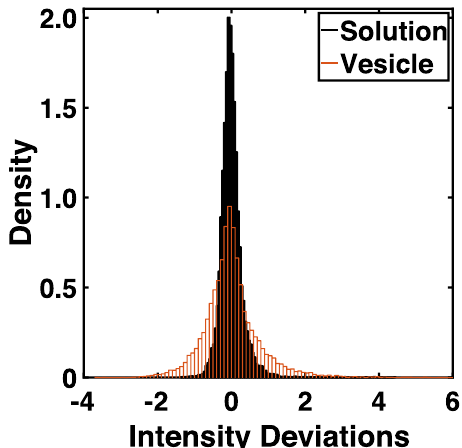
Fig. 2 | Peptides on vesicles at the estimated poration are not distributed randomly. The intensity deviations in solution (black) are narrower around 0 deviation (mean= − 3.9e-5, variance=0.096) while the intensity deviations for the bound peptide (red) include deviations greater than the largest deviations observed insolution(mean=0.005,variance=0.598).Sourcedataareprovidedas a Source Data fi